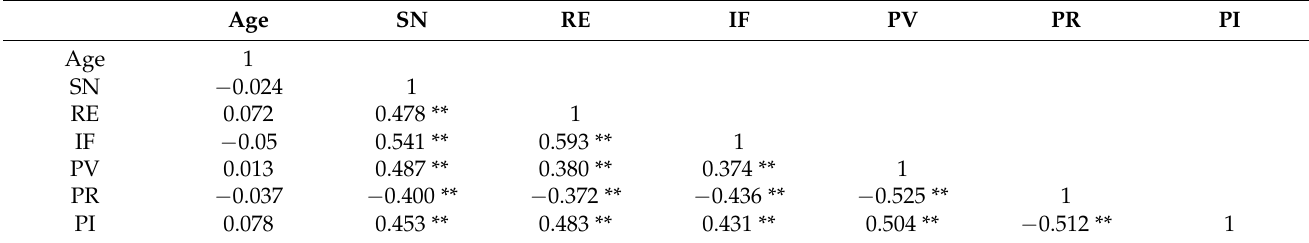
Table 5. Correlation coefficient matrix between age and each